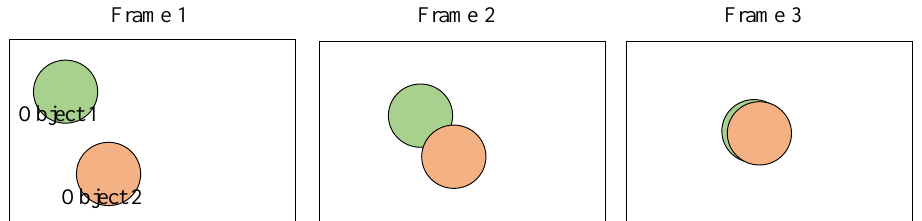
Figure 6. Visualization of the occlusion for two objects (orange and green). The objects in frame 1 are not overlapping. The objects in frame 2 are slightly overlapped, which is called occlusion. For frame 3, the green object is almost fully occluded by the orange